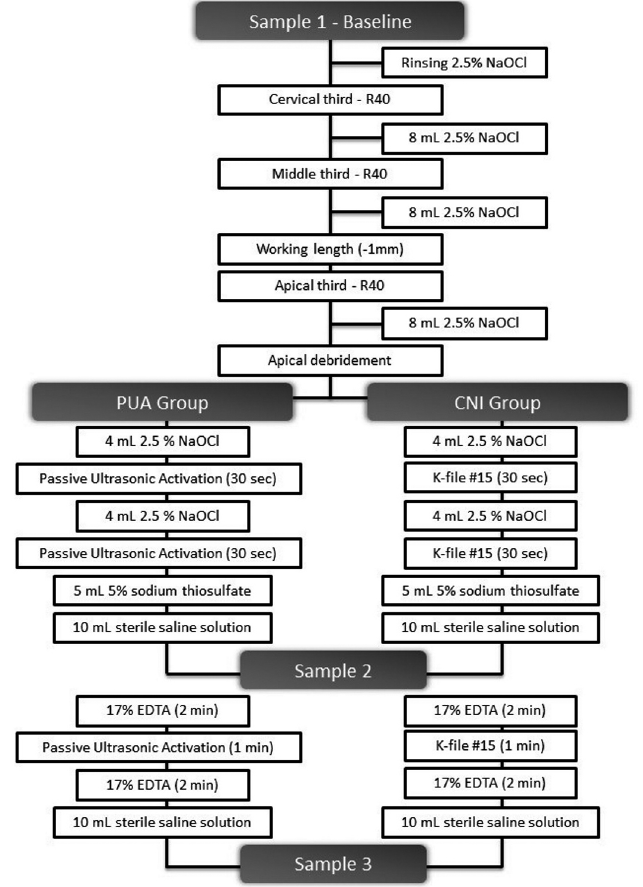
Figure 2- Flow diagram of interventions and sampling